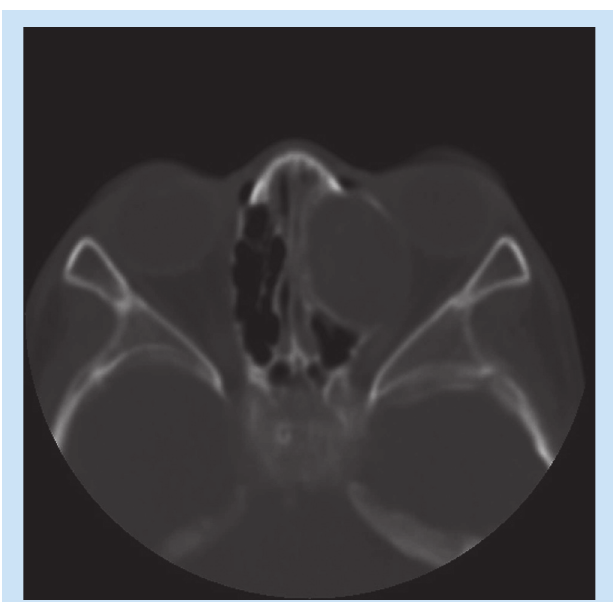
Fig. 3. Axial CT scan (bone window). There is evidence of thinning and remodelling of the walls of the expanded left ethmoid sinus. There is no evidence of bony